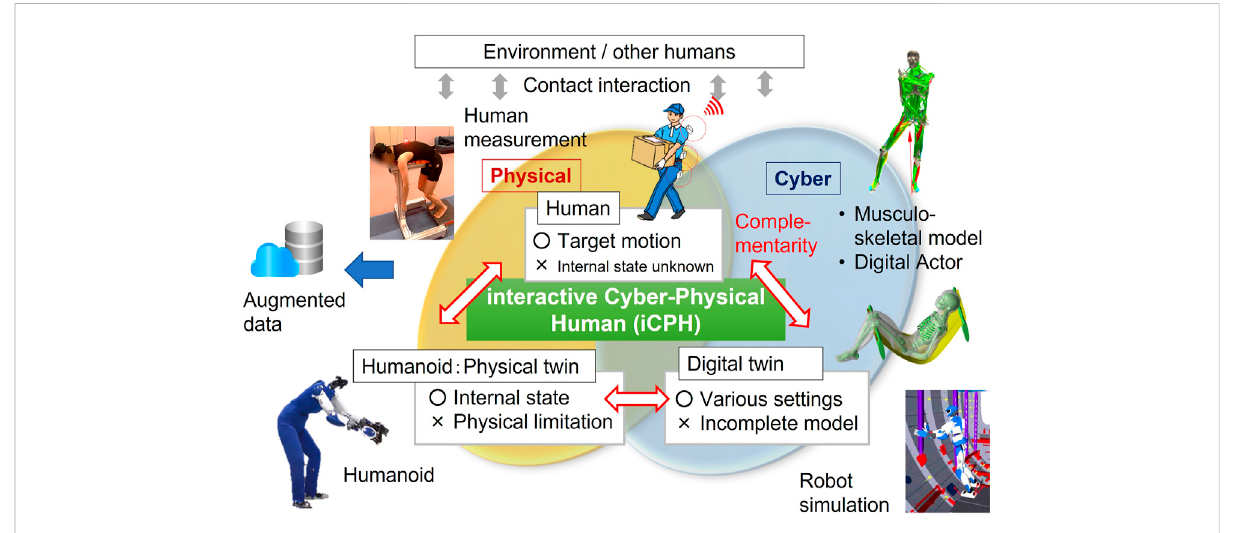
FIGURE 1 Platform of interactive cyber-physical human (iCPH) for investigation of contact-rich whole-body motion of anthropomorphic